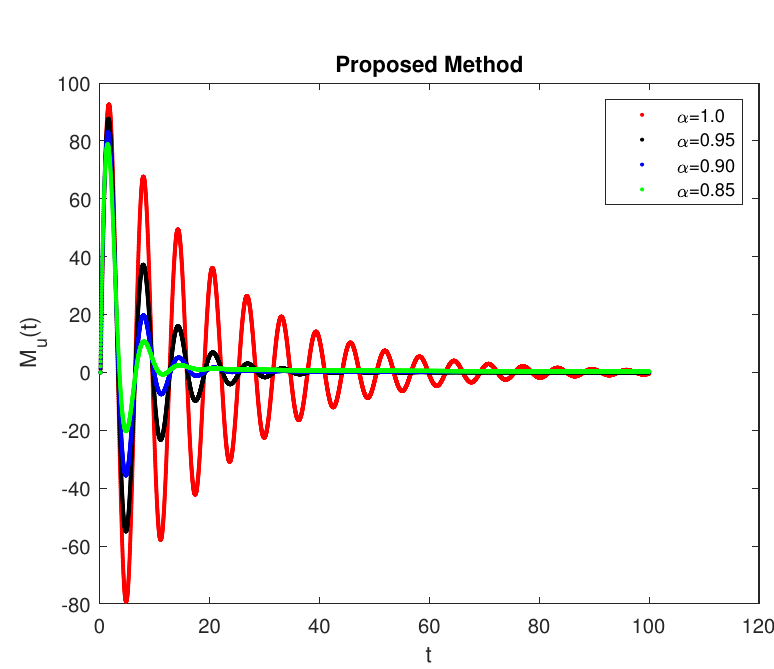
Figure 10: Numerical simulations for τ = 1 for Caputo